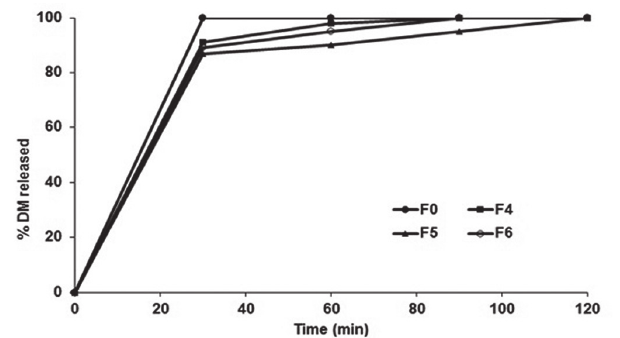
FIGURE 5 ‑ In vitro release profiles of DM from pellets formulations prepared from different HPMC K10 concentrations.